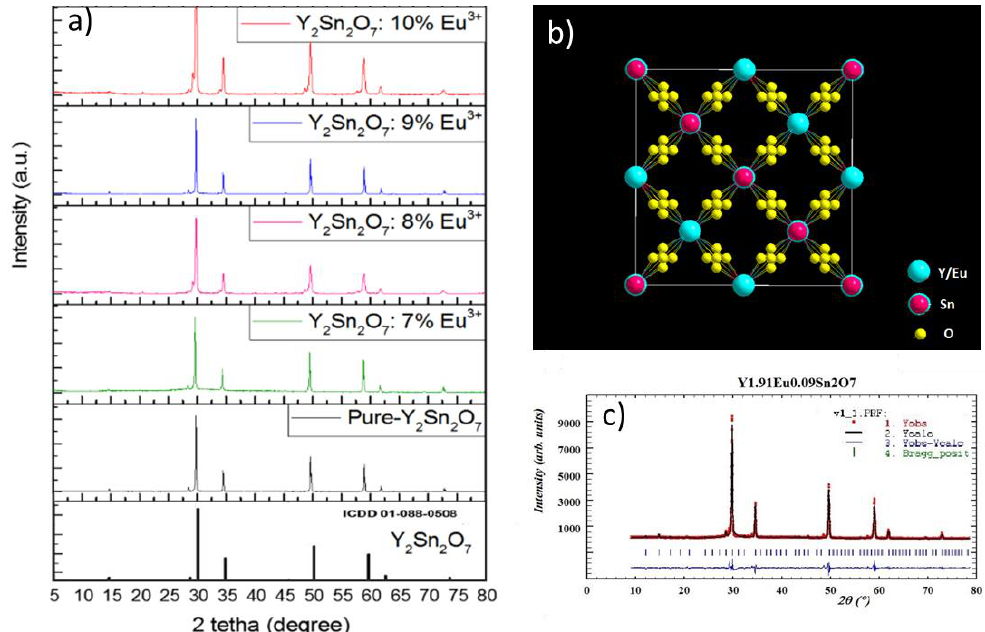
Figure 1. ( a ) Powder XRD patterns of the undoped and doped Y 2 Sn 2 O 7 samples compared to the JCPDS card for pure pyrochlore structure. ( b ) Crystal structure of doped Y 2 Sn 2 O 7 . ( c ) Fitting results on one of the spectra.